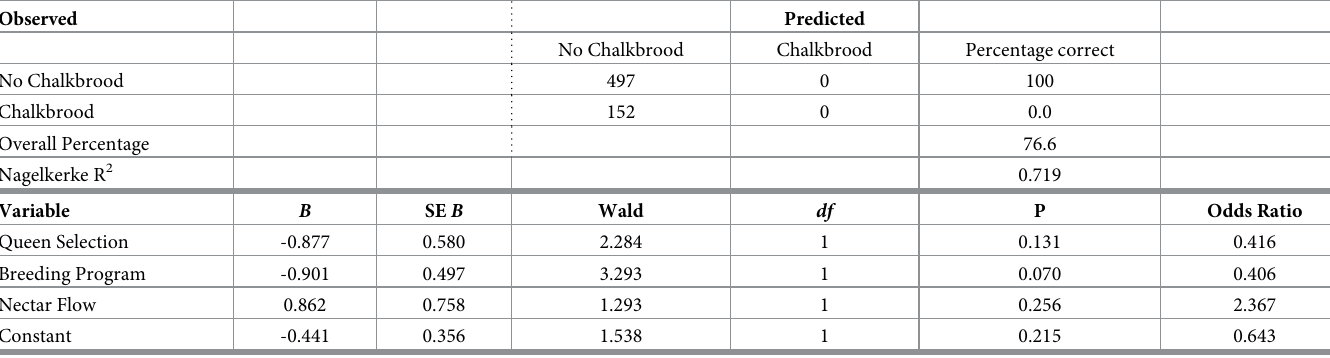
Table 5. Summary of logistic regression analysis for variables predicting chalkbrood infection. Dependent variable: chalkbrood presence (n = 649).